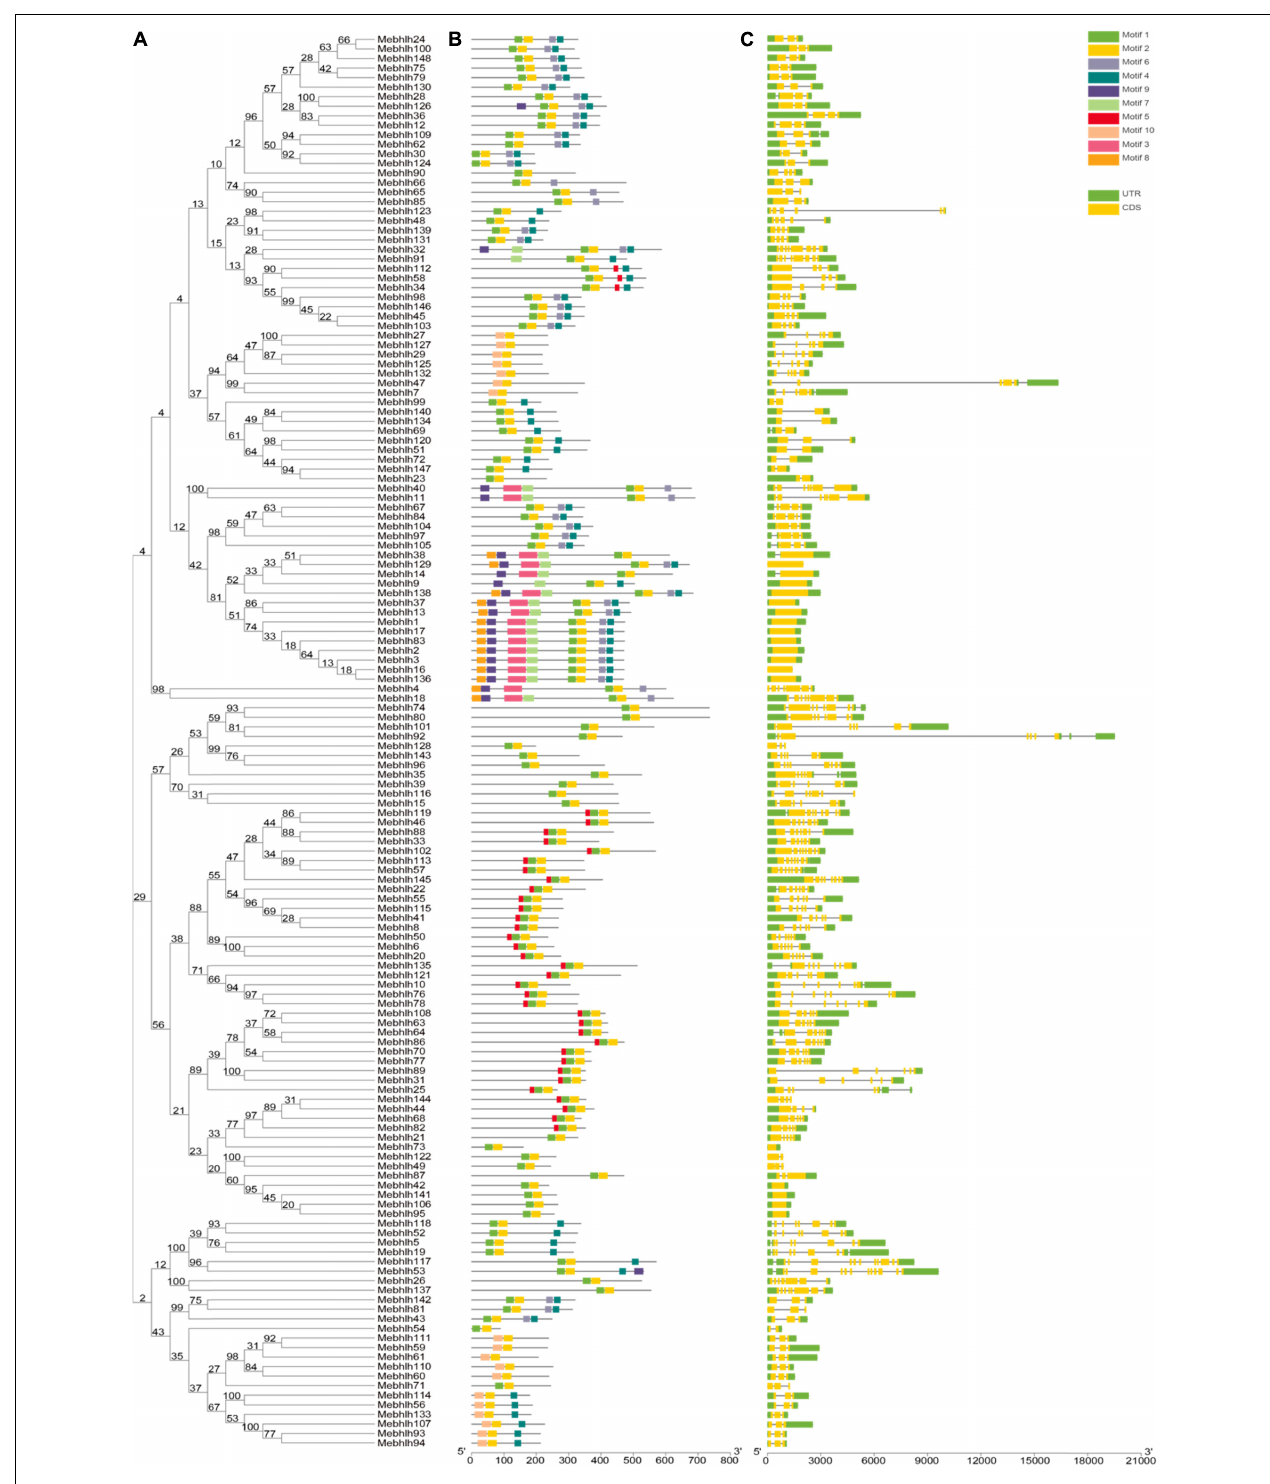
FIGURE 5 | Putative conserved motifs and gene structures of the MebHLH genes. (A) Multiple sequence alignment of bHLH domain sequences of M. esculenta was performed using ClustalW. The neighbor-joining (NJ) tree was constructed using MEGA X with 1,000 bootstrap replicates. (B) Conserved motif. MEME analysis revealed the conserved motifs of the MebHLH proteins. The colored boxes on the right denote 10 motifs. (C) Gene structure. The yellow boxes, black lines, and green boxes represent exon, intron, and UTR (untranslated region), respectively.